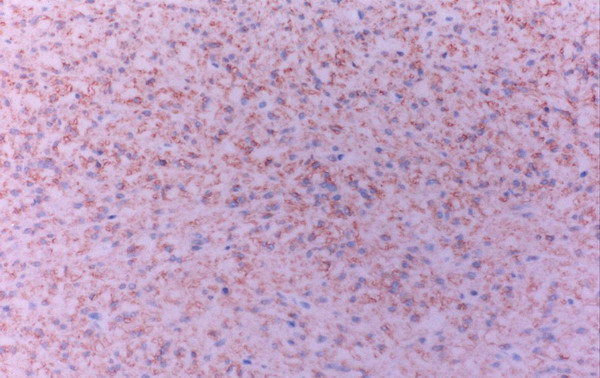
The tumor cells were immunopositive for C-kit (CD117). (× 100, H &E).